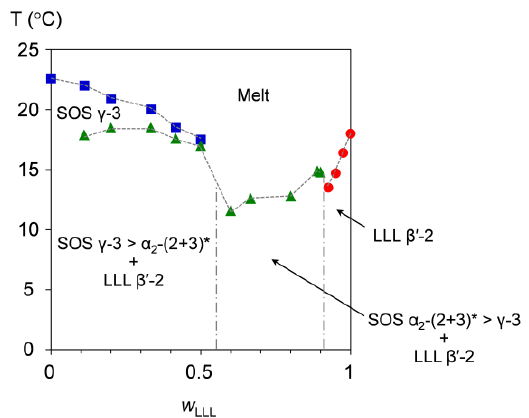
Figure 9. Melt-crystallization kinetic phase behavior of SOS/LLL as a function of w LLL , depicted for cooling at a rate of 2 °C/min. Symbols represent the phase-transition temperatures due to the exothermic effects of SOS (blue square), LLL (red circle), and SOS + LLL (green triangle). * Transitional structure of SOS α 2 -(2 + 3) is defined in reference [50].